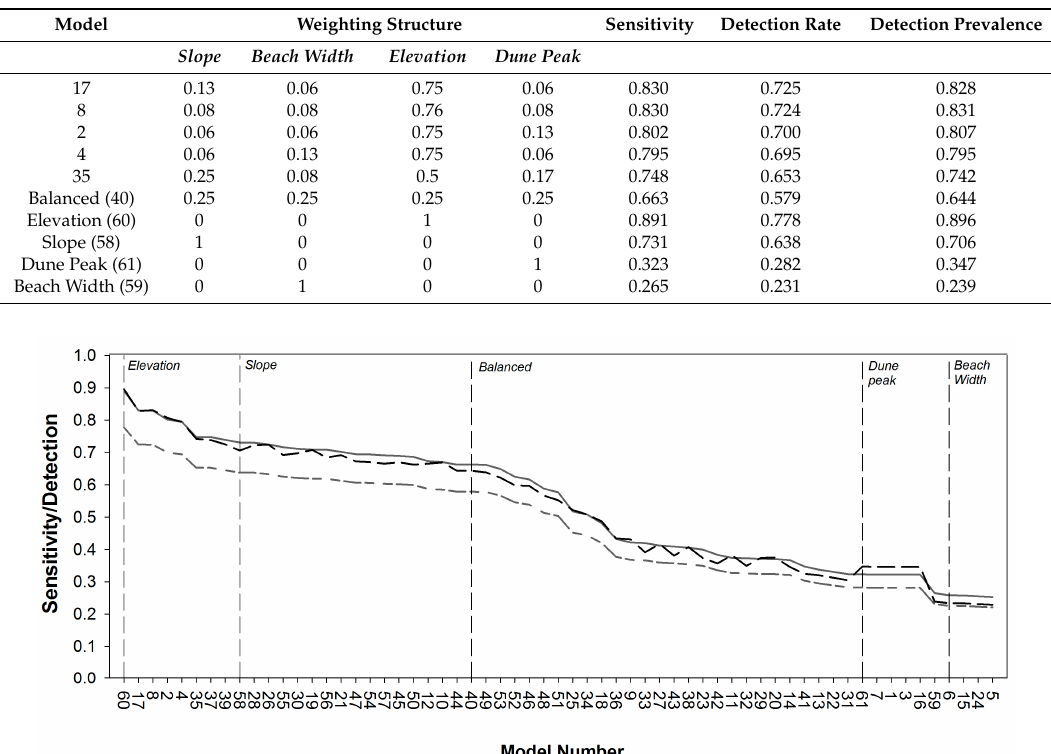
Figure 5. Sensitivity (solid gray line), detection prevalence (dashed black line), and detection rate (gray dashed line) for predicting the occurrence of C. caretta nests for each of the 61 models tested. The weighting scheme for each model is listed in Appendix B.